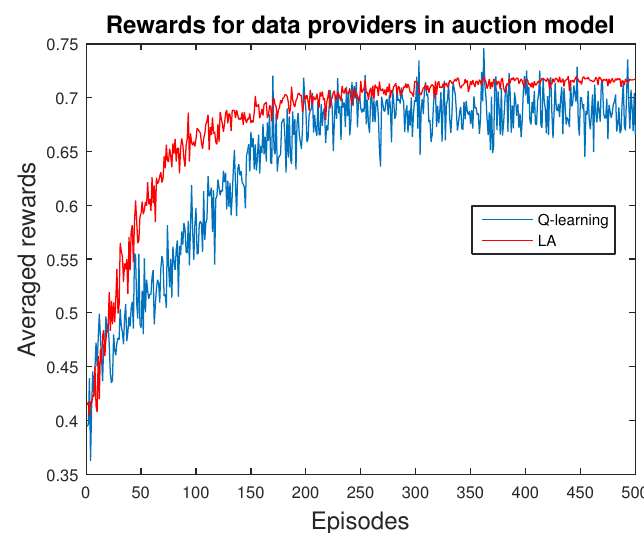
Figure 6. Rewards of data providers in the auction model. It is obviously that agents in the LA method obtain more rewards, indicating that their choices are superior. These learning curves can also demonstrate the efficiency of learning.